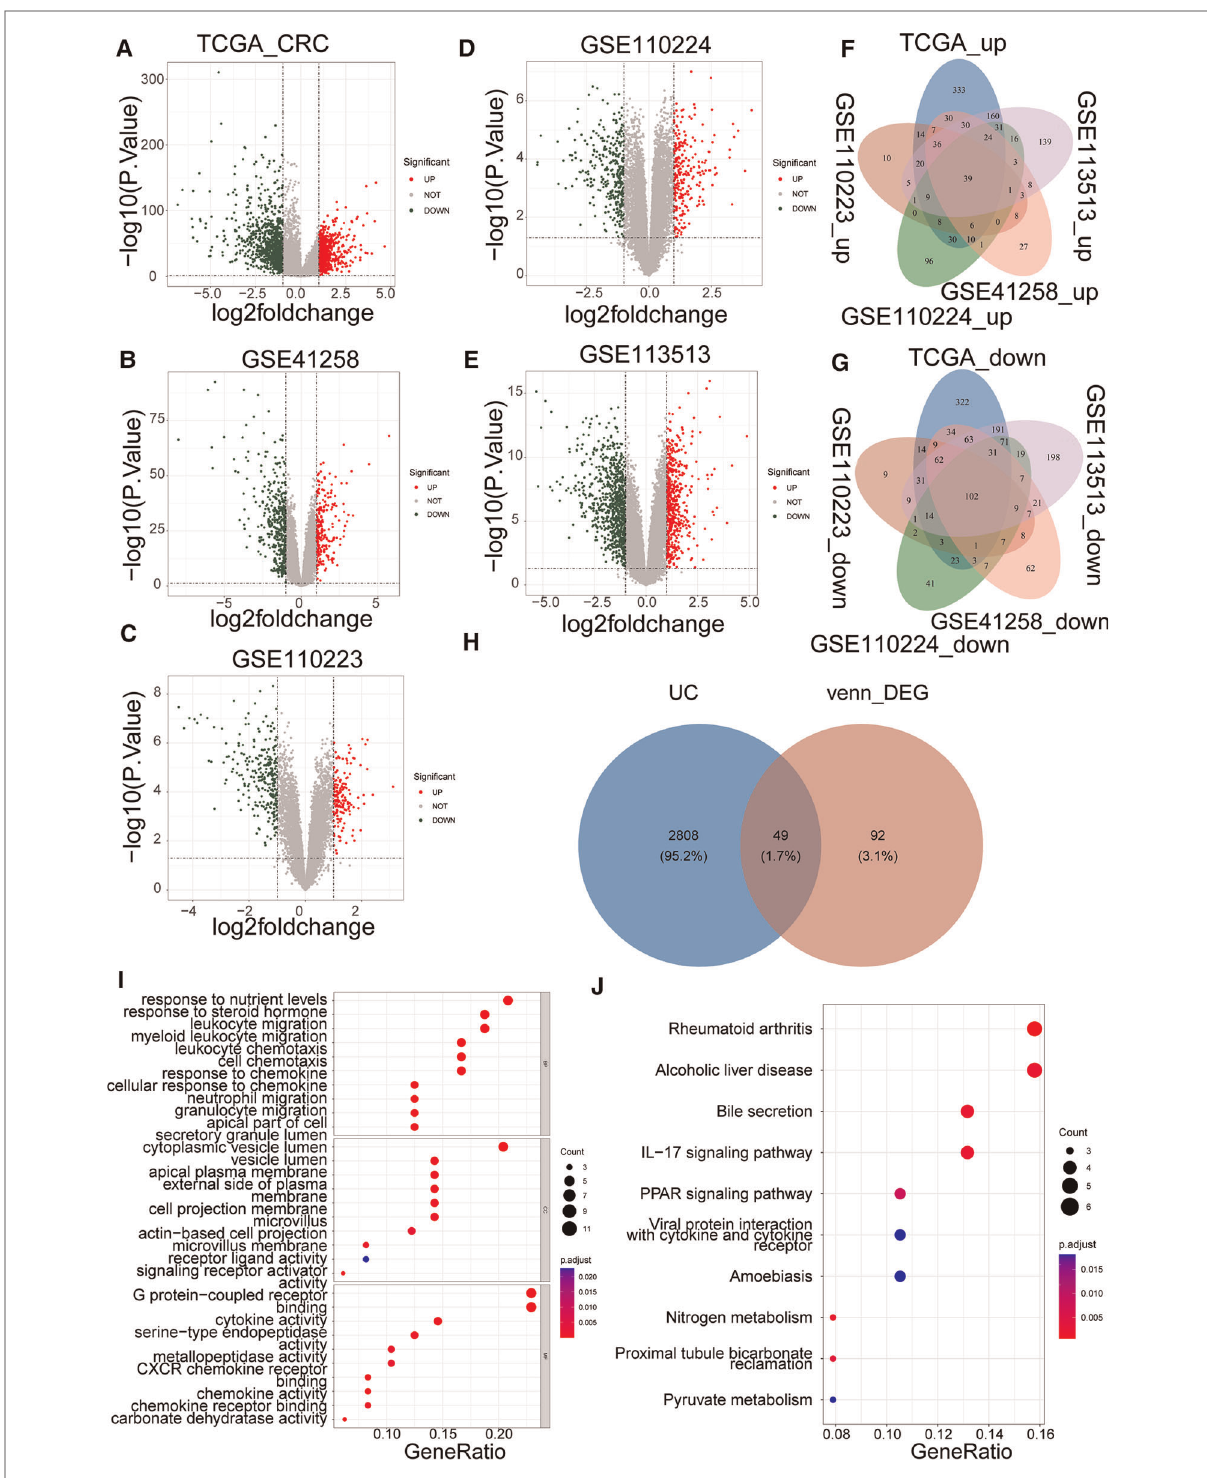
FIGURE 1 Identi fi cation of colorectal cancer (CRC)-associated differentially expressed UC-related genes (DEUCRGs) in the cancer genome atlas (TCGA) and gene expression omnibus (GEO) cohorts. Volcano plots of DEGs in ( A ) TCGA-CRC, ( B ) GSE110223, ( C ) GSE41258, ( D ) GSE110224, and ( E ) GSE113513 datasets. ( F ) Venn diagram of upregulated genes in fi ve datasets. ( G ) Venn diagram of downregulated genes in fi ve datasets. ( H ) Venn diagram for identifying DEUCRGs. ( I ) Top 10 Gene Ontology (GO) terms enriched by DEUCRGs under cellular component (CC), molecular function (MF), and biological process (BP) subcategories. ( J ) Top 10 Kyoto Encyclopedia of Genes and Genomes (KEGG) pathways enriched by